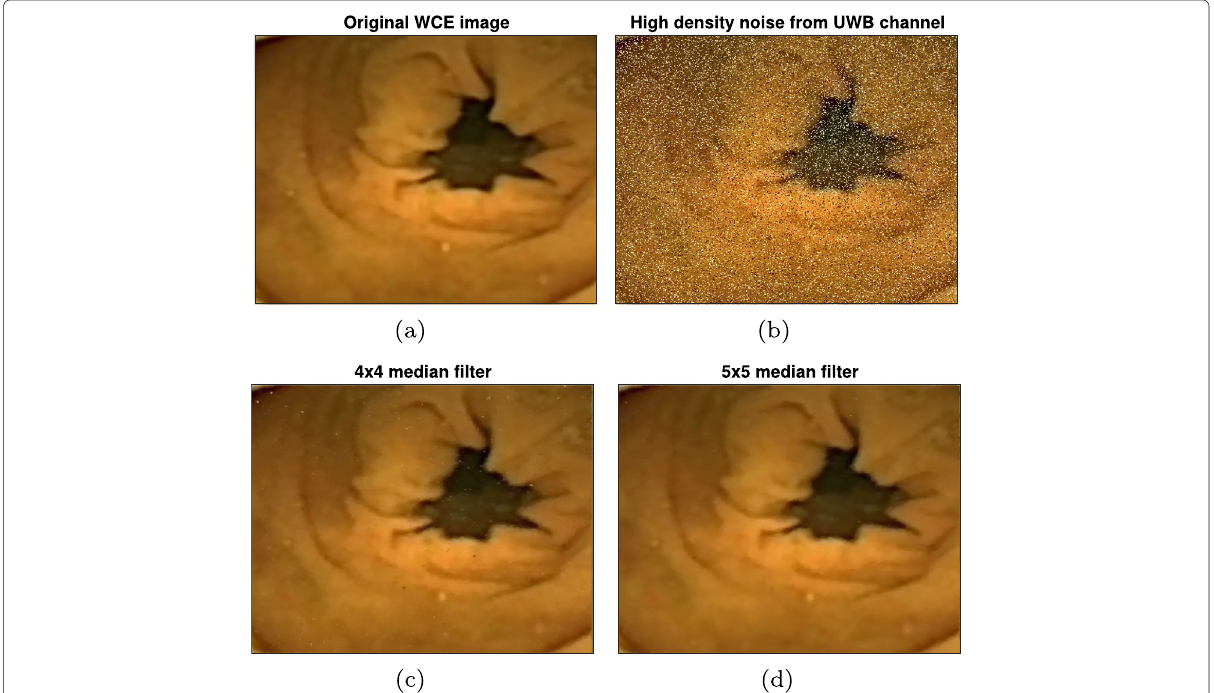
Fig. 2 a Original WCE image. b WCE image with massive errors from UWB PPM simulation. SSIM = 0.05 c Corrected image: 4 × 4 median filter. SSIM = 0.93. d Corrected image: 5 × 5 median filter. SSIM =